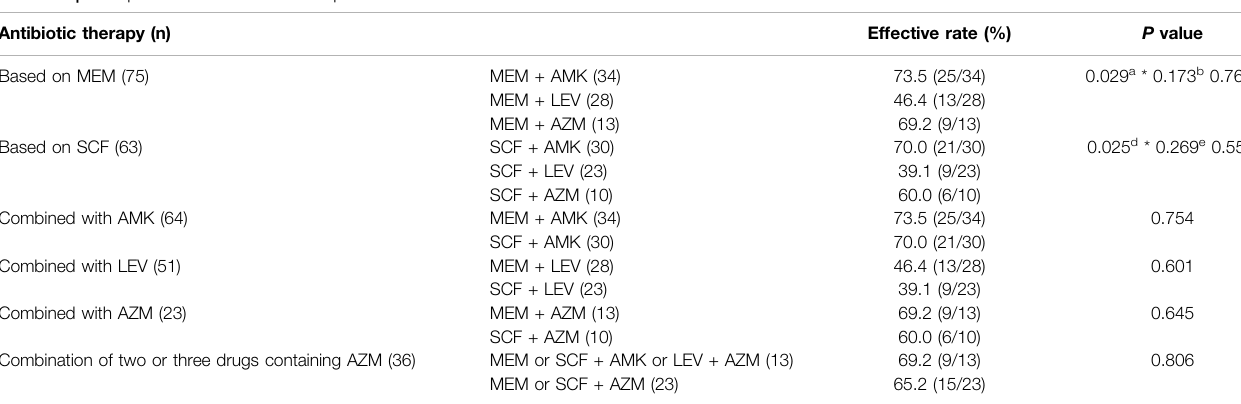
TABLE 4 | Therapeutic effect of different empirical schemes. Antibiotic therapy